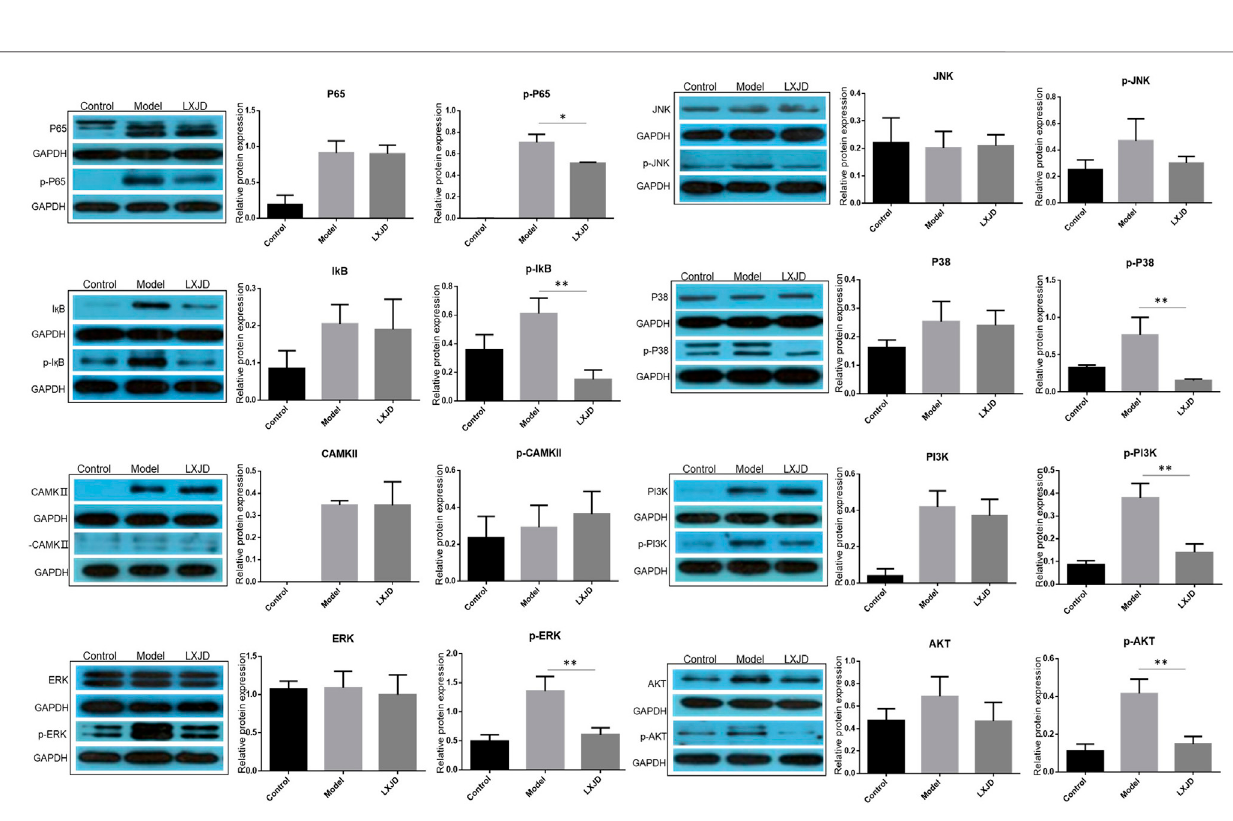
Frontiers in Pharmacology |